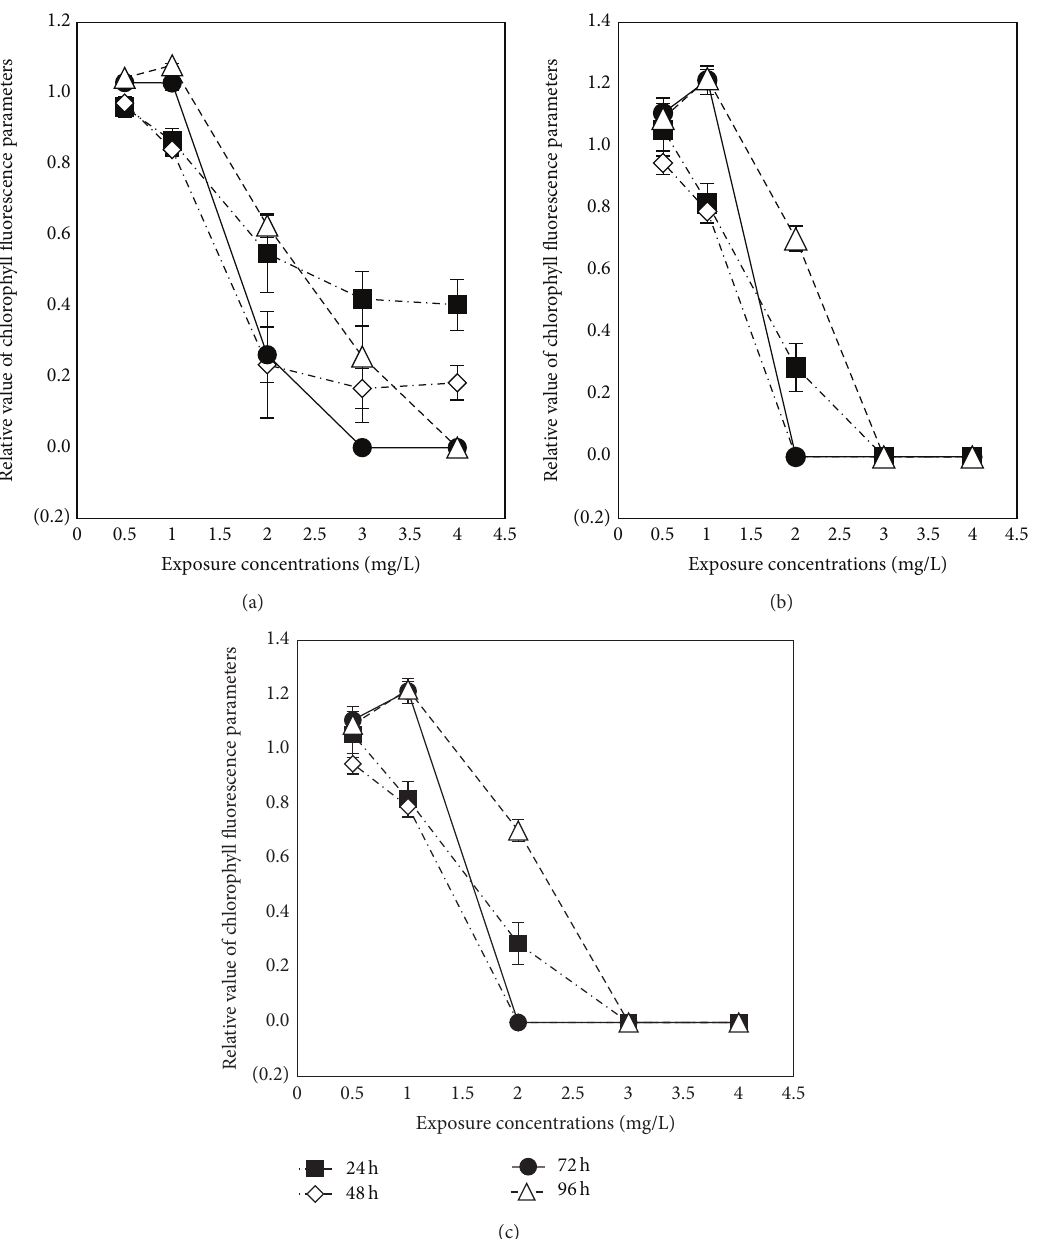
Figure 5: The effects of ethyl cinnamate on the 𝐹 V /𝐹 𝑚 , B PSII , and ETR of C. vulgaris . ((a) 𝐹 V /𝐹 𝑚 ; (b) B PSII ; (c) ETR.) (The relative value of chlorophyll fluorescence parameters: treatment-to-blank control ratio of chlorophyll fluorescence